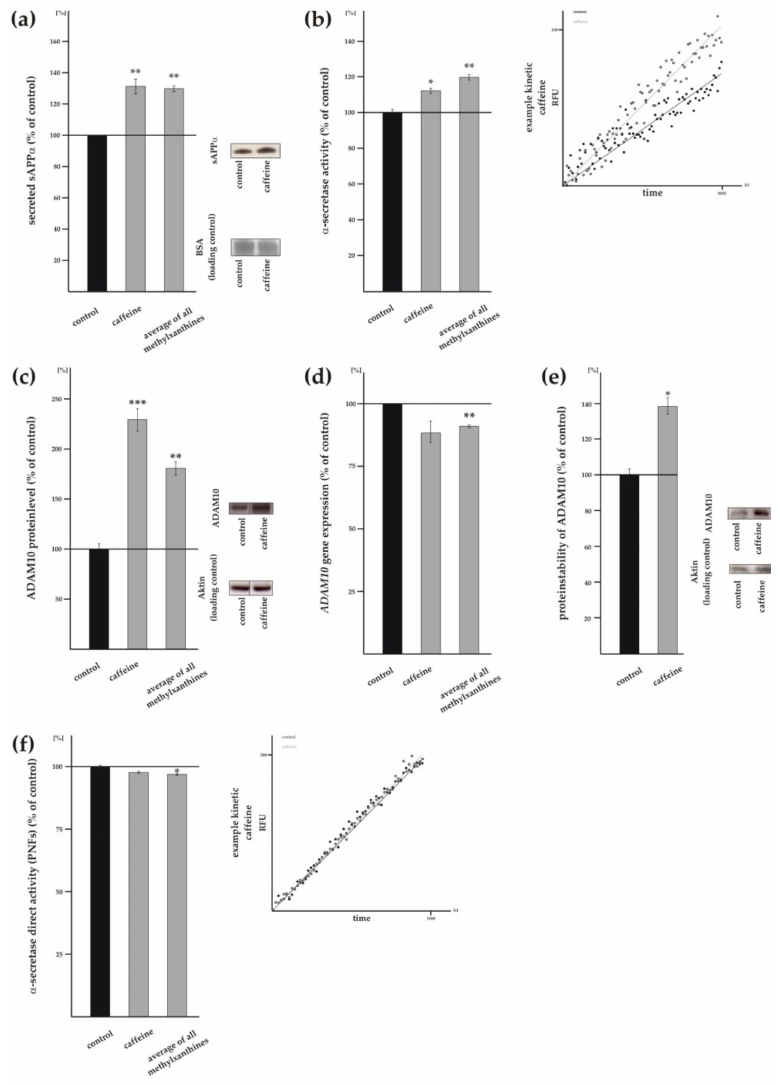
Figure 3. E ff ects of ca ff eine and other MTXs on non-amyloidogenic APP processing. ( a ) Secreted soluble sAPP α of treated SH-SY5Y cells ( n ≥ 9) and representative western blots (WBs) including load control. ( b ) Analysis of the α -secretase activity in living SH-SH5Y cells after treatment with MTXs ( n ≥ 4). A representative kinetic of ca ff eine is shown in the right part of the figure. ( c ) Protein level of ADAM10 ( n ≥ 4) and representative WBs including load control. ( d ) RT-PCR analysis of ADAM10 compared to control conditions ( n ≥ 10). ( e ) Determination of ADAM10 degradation ( n ≥ 4). Representative WBs including load control are shown on the right. ( f ) α -secretase activity in post nuclear fractions of incubated SH-SY5Y cells ( n ≥ 4) and representative kinetic after treatment with ca ff eine. Error bars represent the standard error of the mean. Asterisks show the statistical significance calculated by unpaired Student’s t test (* p ≤ 0.05; ** p ≤ 0.01; *** p ≤